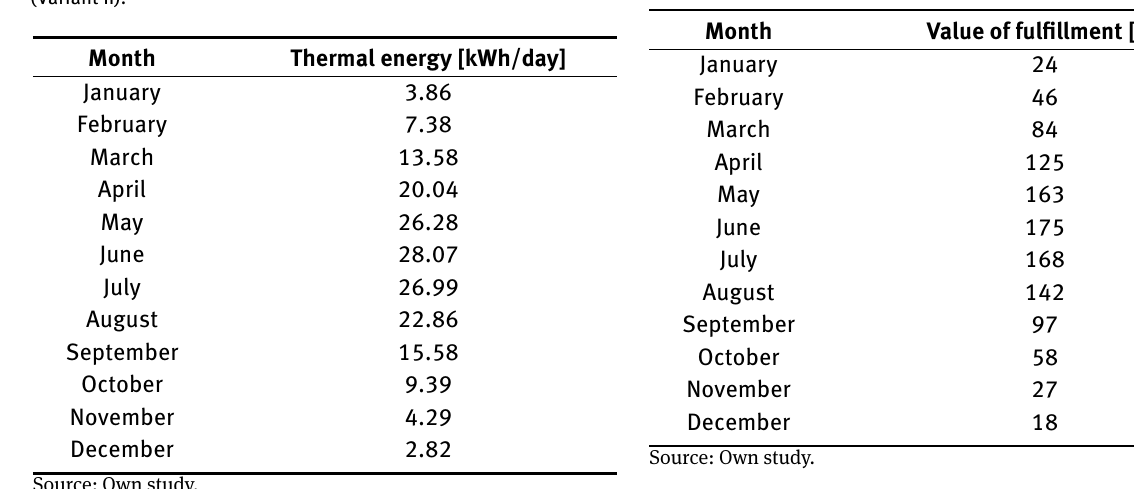
Table 8: Degree of meeting the